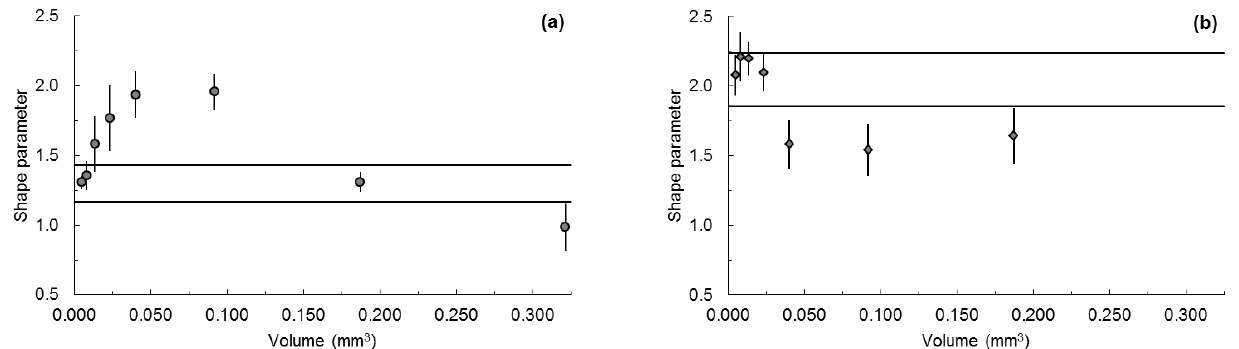
Figure 2. Mean ± SE of shape parameter c in relation to seeds size. Horizontal lines show the 95% confidence intervals of the means of all sizes combined: ( a ) spherical seeds; ( b ) non-spherical seeds. Volume of seeds refers to the highest value in each interval resulting from the sequential sieving.